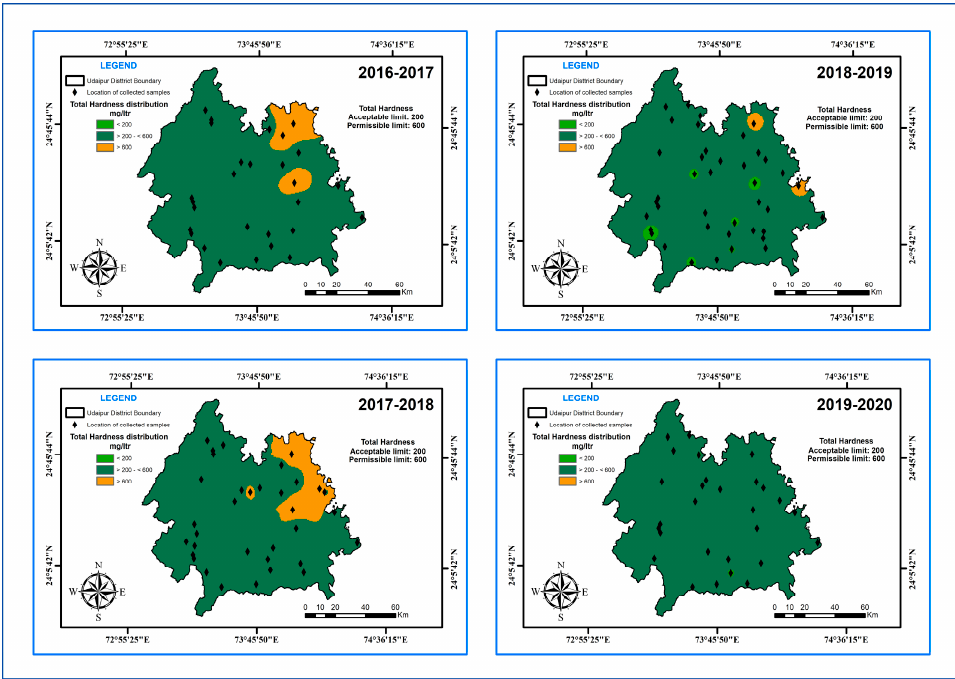
Figure 19. The changing distribution of total hardness from 2016–2018 in the study area.